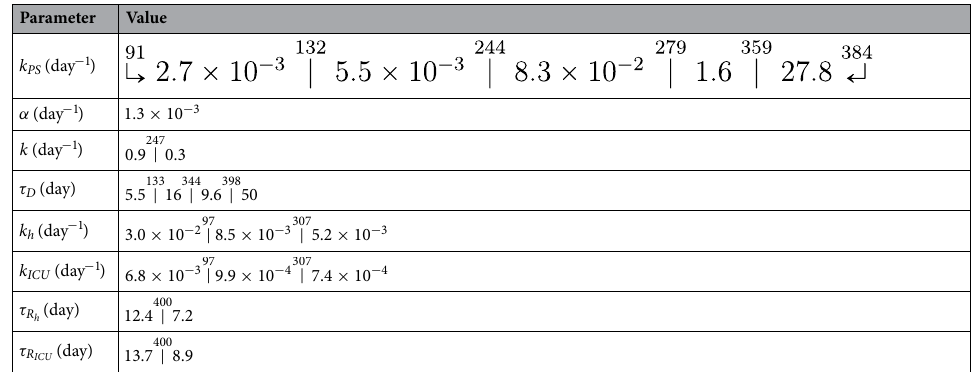
Table 2. Model fitting optimized parameters. Some of the parameters fitted vary discretely with time. In that case, the value of the parameter is preceded by the day from which it applies and may be followed by the day from which it no longer